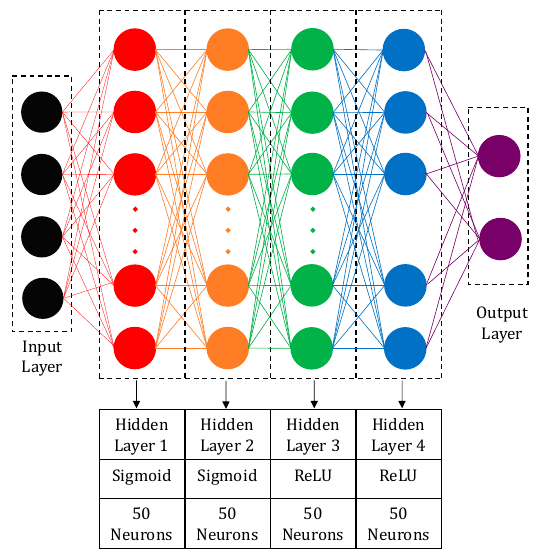
Figure 4. Deep neural network supervised training.